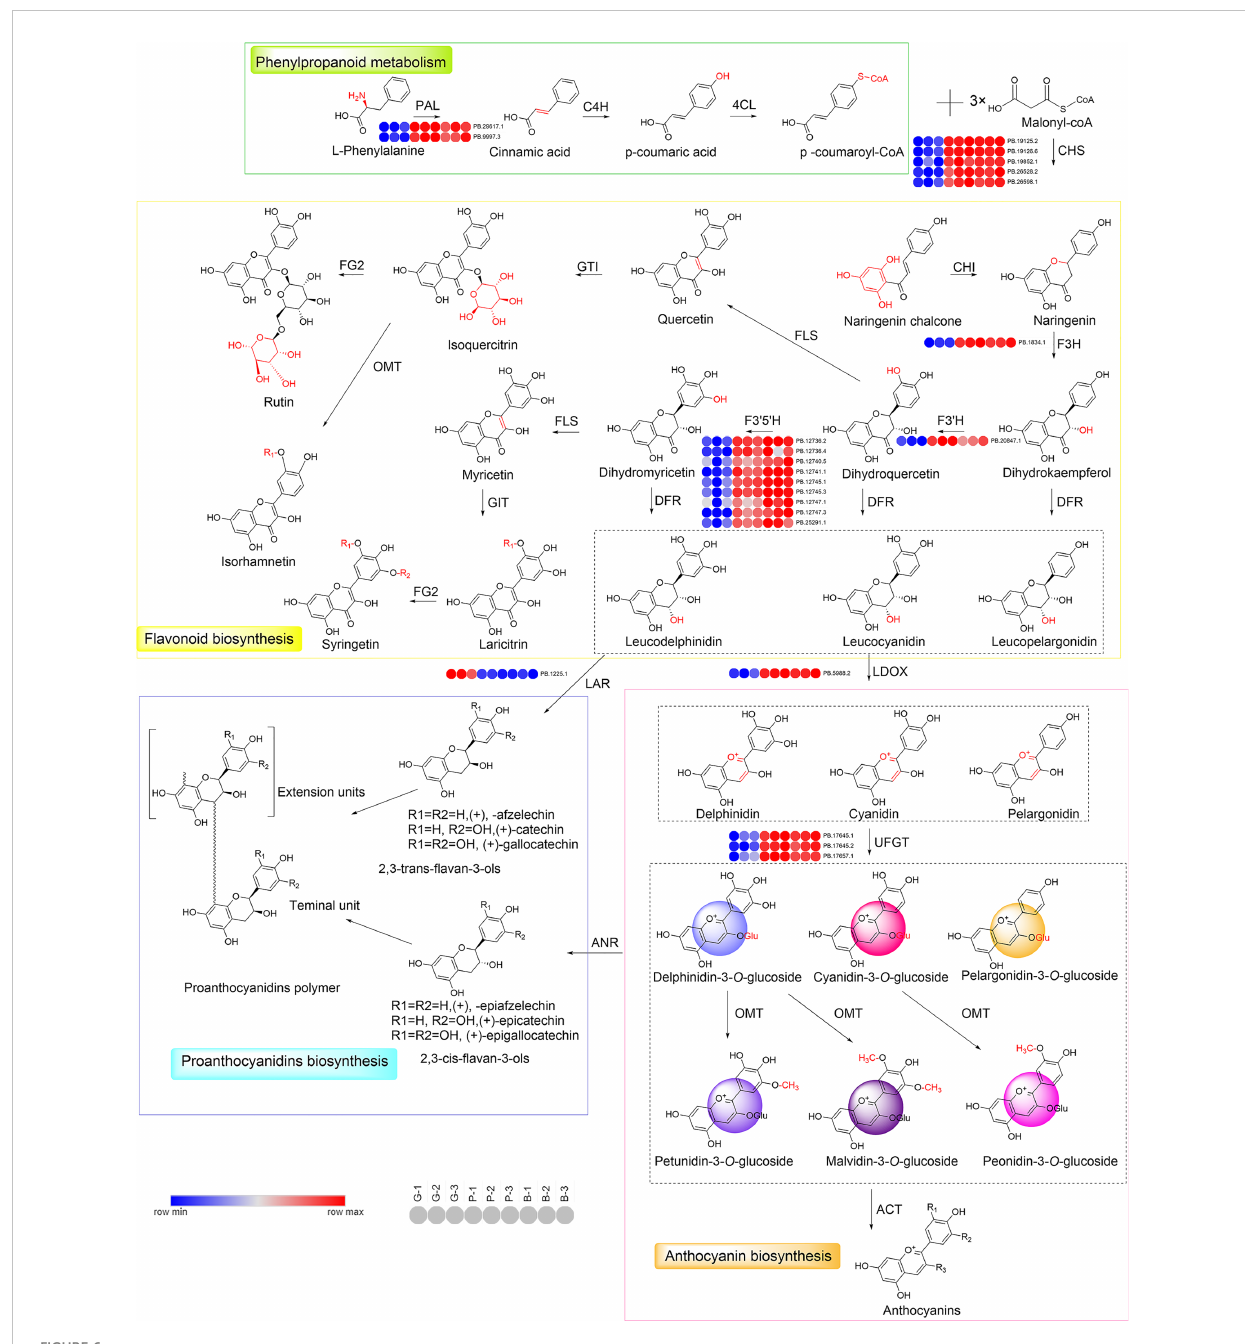
FIGURE 6 Reconstruction of the phenylpropanoid- fl avonoid-anthocyanin biosynthesis pathway in Misty blueberry. The typical colors of anthocyanidins are also shown. PAL , phenylalanine ammonia lyase; C4H , cinnamate 4-hydroxylase; 4CL , 4-coumarate-CoA ligase; CHS , chalcone synthase; CHI , chalcone isomerase; F3H , fl avanone 3-hydroxylase; F3 ′ H , fl avonoid 3 ′ -hydroxylase; F3 ′ 5 ′ H , fl avonoid 3 ′ , 5 ′ -hydroxylase; FLS , fl avonol synthase; GTI , Anthocyanidin 5, 3- O -glucosyltransferase; FG2 , fl avonol-3- O -glucoside L-rhamnosyltransferase; DFR , dihydro fl avonol 4-reductase; OMT , o- methyltransferase; LDOX , Leucoanthocyanidin Dioxygenase; UFGT , UDP-glucose fl avonoid 3- O -glucosyltransferase; LAR , leucoanthocyanidin reductase; ANS , Anthocyanidin synthase; ACT , anthocyanin acyltransferase. G, green stage; P, pink stage; B, blue